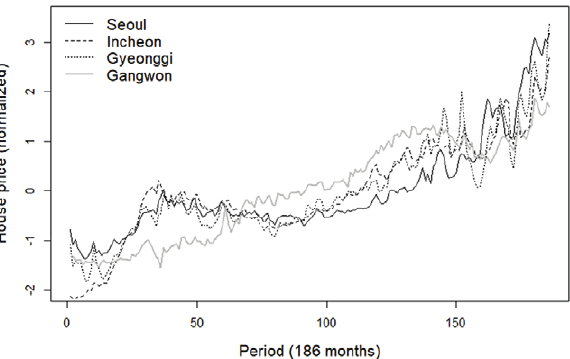
Figure 3. Fluctuations in house prices between Jan. 2006 and Jun. 2021